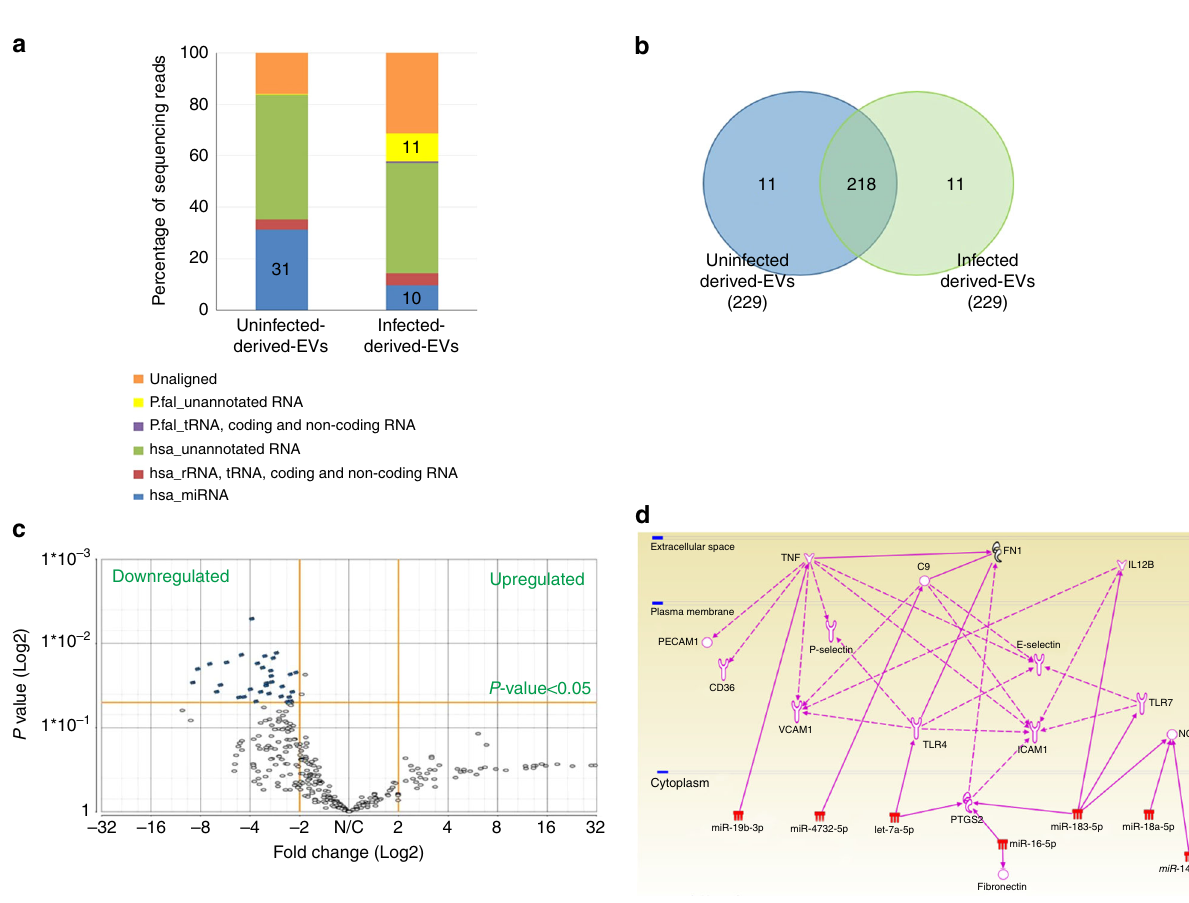
Fig. 2 Packaging of the P. falciparum RNA species into EVs. a Bar graph of annotated and unannotated reads calculated as a percentage of total reads of each sample (Supplementary Table 1). Percentage alignment and mapping to H. sapiens (hg19; miRBase v.20, Ensembl v74 and tRNAscan-SE) and P. falciparum (ASM276v1; EnsemblProtists and tRNAscan-SE) genome and annotations from small RNA sequencing. b Venn diagram of the number of highly abundant miRNA species in iRBC-derived-EVs and uRBC vesicles. c Volcano plot of differentially expressed human miRNA in iRBC-derived EVs and uRBC- derived EVs (Supplementary Table 3). Normalized reads to RPM. ANOVA analysis, highlighted in blue: p ≤ 0.05 (iRBC-ex vs uRBC-v) and ± 2.0 fold change. d Pathway analysis of mRNA targets of miRNA differentially detected in EVs from iRBCs. Ingenuity Pathway Analysis 75 was used to fi nd direct and indirect relationships, with the validated human mature miRNA differently expressed in EVs from iRBCs and mRNA related to malaria. All edges are supported by at least 1 reference from the literature or from canonical information stored in the Ingenuity Pathways Knowledge Base. Downregulation or the absence of these miRNAs in vesicles would allow protein translation to occur without